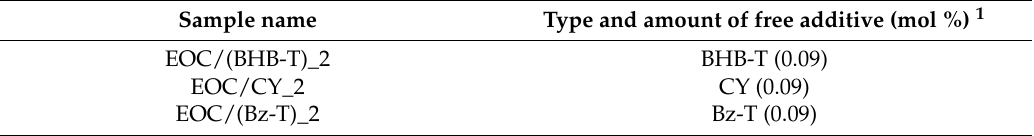
Table 2. Polymer mixtures: amount of mixed